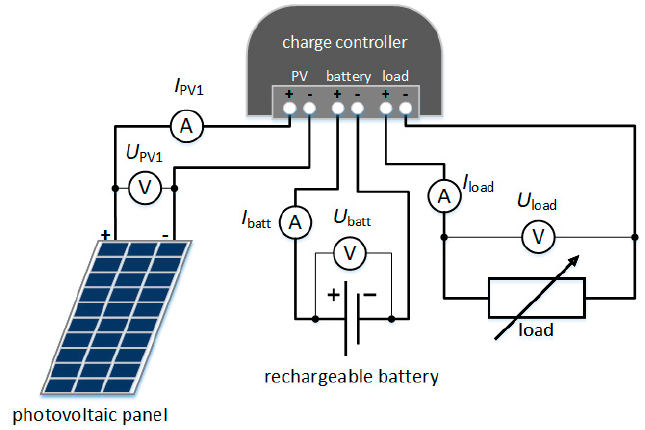
Figure 5. Scheme of the PV-battery experimental setup.